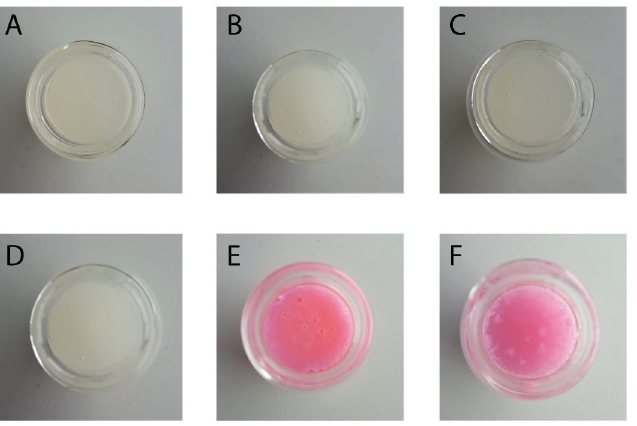
Fig 4. Appearance of HU oral liquids. A, Mortar—Original capsules; B, Mortar—Generic Capsules; C, Mortar— Powder; D, Mixer—Powder; E, QuartetRx—Original capsules; F, QuartetRx—Generic